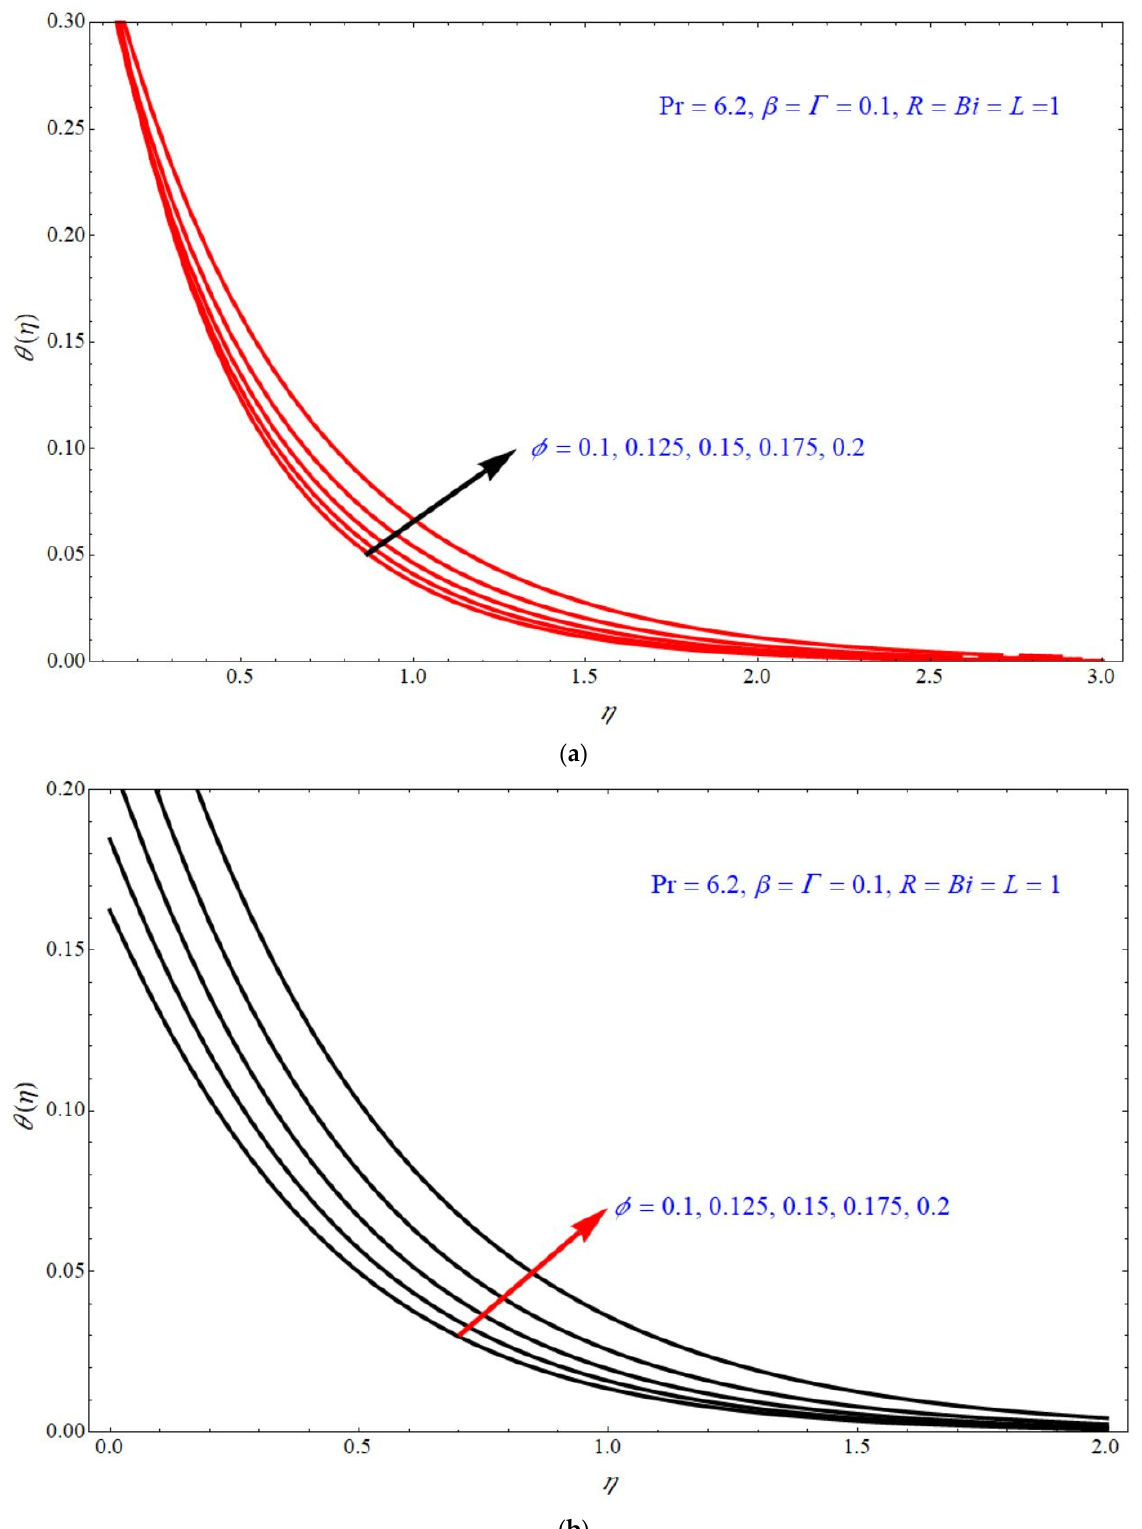
= − . Figure 6. Impact of θ ( η ) on η for various choices of φ at ( a ) d = 1 and ( b ) d = −